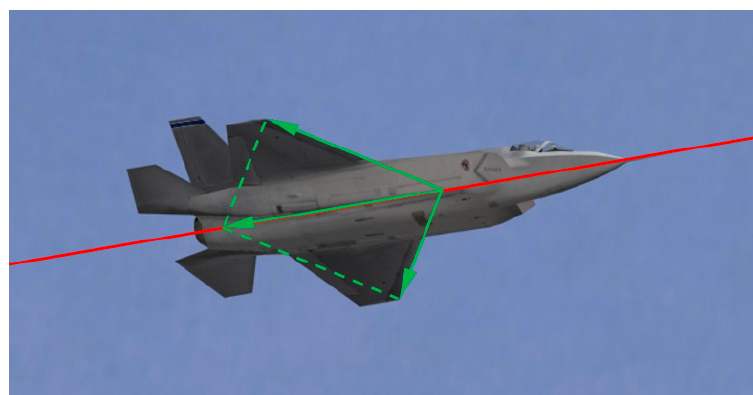
Figure 5. The geometric constraint of the directed wing leading edges and fuselage reference line in the image frame.